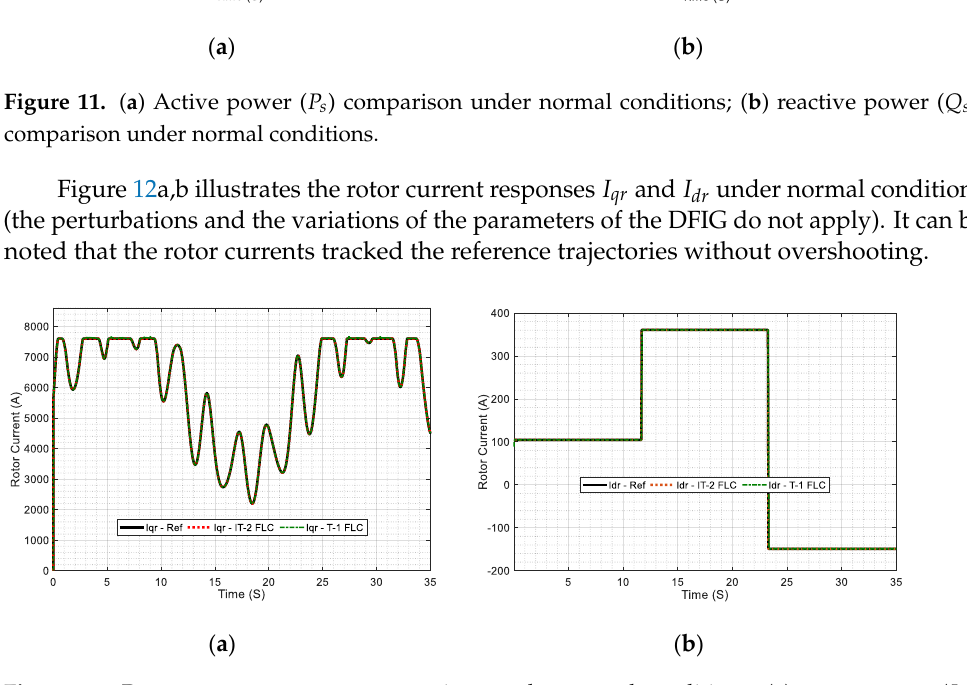
Figure 12. Rotor current response comparison under normal conditions; ( a ) rotor current ( 𝐼 𝑞𝑟 ); ( b ) rotor current ( 𝐼 𝑑𝑟 ).